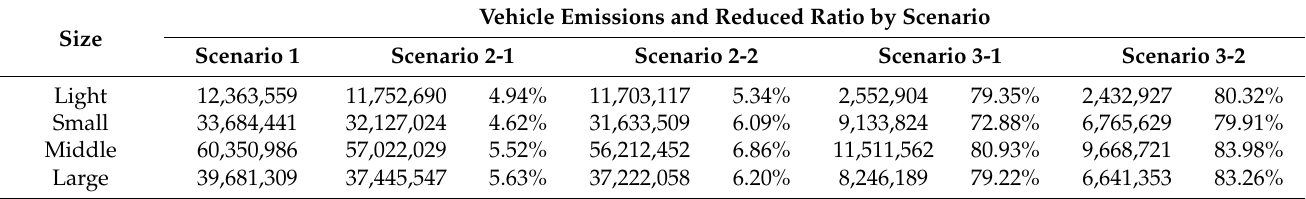
Table 5. Vehicular emissions and reduction efficiency by vehicle size.